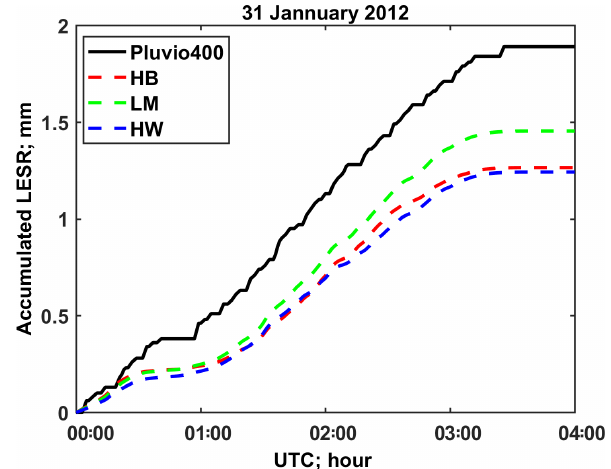
Figure 10. Comparison of liquid equivalent accumulations com- puted using HB, LM, and HW methods based on 2DVD measure- ments and that were directly measured by the collocated Pluvio snow gauge. We used the total accumulation to estimate the PSD adjustment factor for the LM and HW methods.